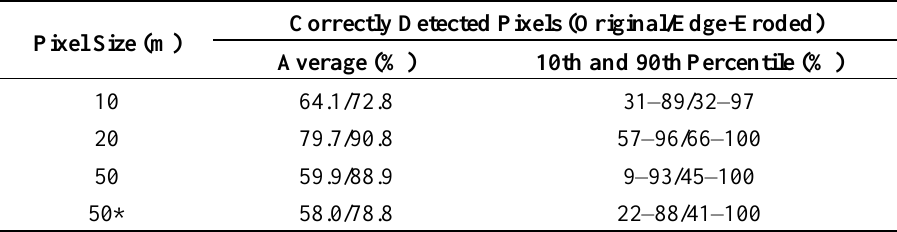
Table 2. Average value, 10th and 90th percentile of the clear-cut distribution of correctly detected pixels with respect to the pixel size of the ALOS PALSAR data. The reference dataset consisted of 31 clear-cuts, where clear-felling took place between ALOS PALSAR image acquisitions. The last line with an asterisk refers to the detection obtained with the simple thresholding algorithm proposed in